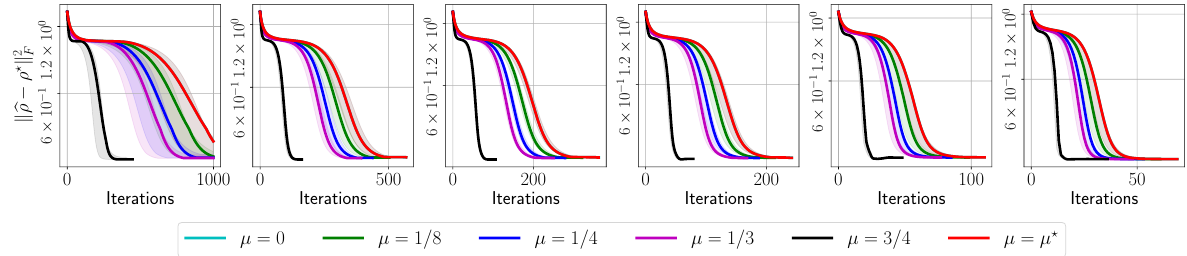
Figure A17. Target error list plots for reconstructing Hadamard ( 8 ) circuit using real measurements from IBM Quantum system experiments.